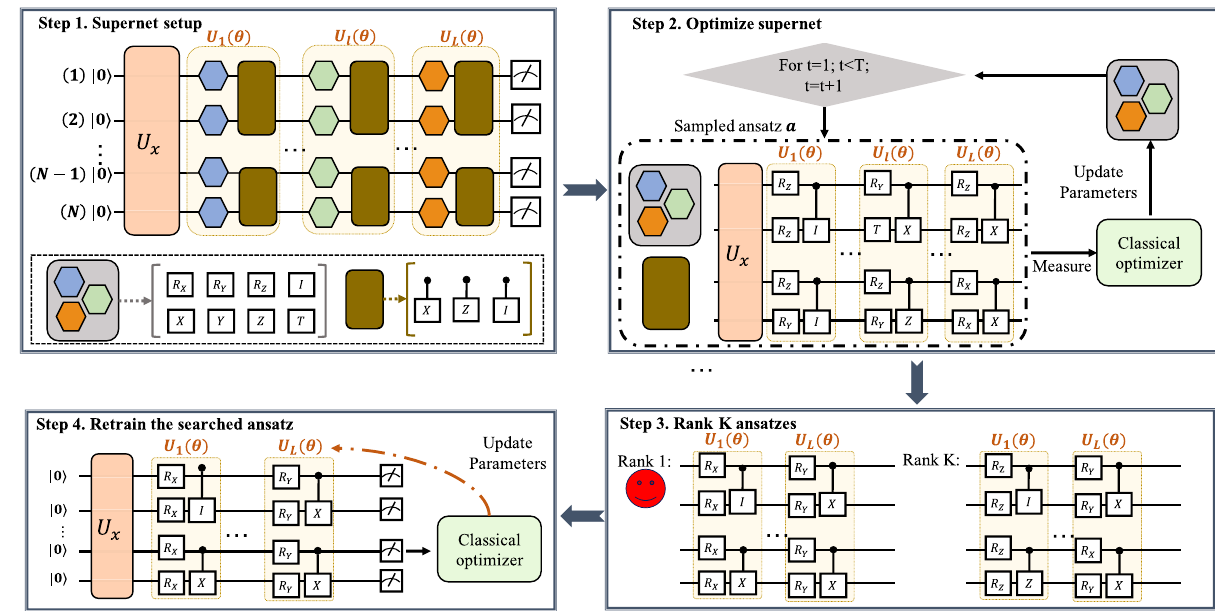
Fig. 1 Paradigm of the quantum architecture search scheme (QAS). In Step 1, QAS sets up supernet A , which de fi nes the ansatze pool S to be searched and parameterizes each ansatz in S via the speci fi ed weight sharing strategy. All possible single-qubit gates are highlighted by hexagons and two-qubit gates are highlighted by the brown rectangle. The unitary U x refers to the data encoding layer. In Step 2, QAS optimizes the trainable parameters for all candidate ansatzes. Given the speci fi ed learning task L , QAS iteratively samples an ansatz a ð t Þ 2 S from A and optimizes its trainable parameters to minimize L . A correlates parameters among different ansatzes via weight sharing strategy. After T iterations, QAS moves to Step 3 and exploits the trained parameters θ ( T ) and the prede fi ned L to compare the performance among K ansatze. The ansatz with the best performance is selected as the output, indicated by a red smiley face. Last, in Step 4, QAS utilizes the searched ansatz and the parameters θ ( T ) to retrain the quantum solver with few